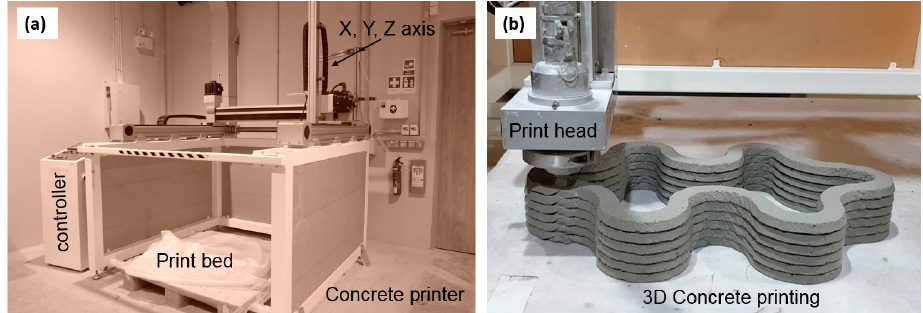
Figure 1. 3D concrete printing (3DCP) equipment at Nanyang Technological University (NTU), Singapore: ( a ) 4-axis concrete gantry printer ( b ) 3DCP process.